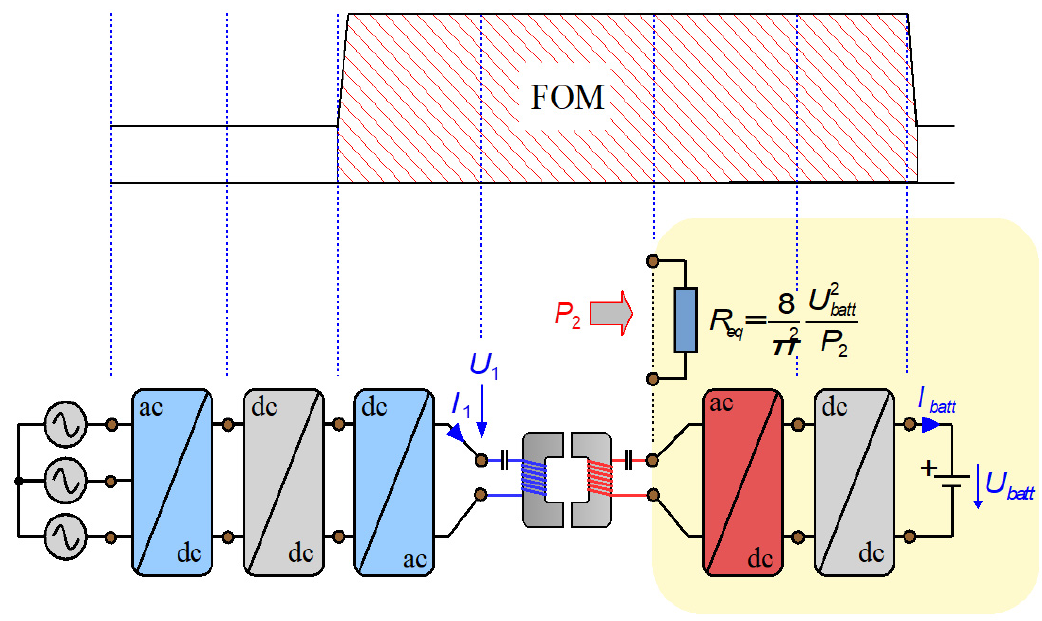
Figure 5. Typical WPT system configuration including dc / dc